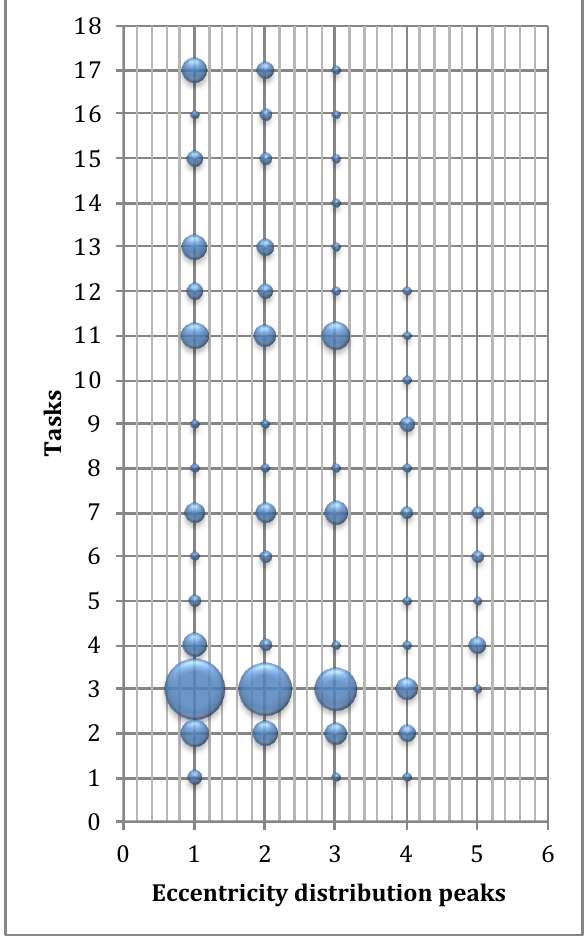
Fig. 6. Tasks presence in the clusters of sessions built based on the number of EDPs; size of bubbles represents the number of occurrences found in the